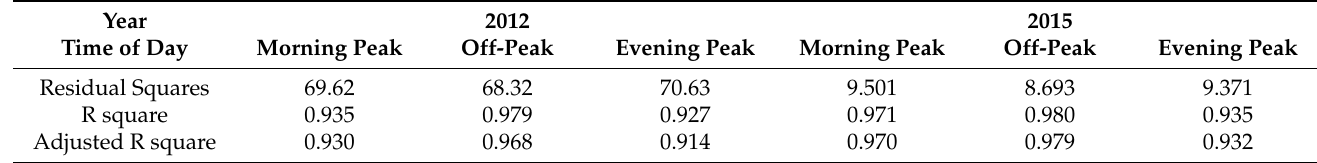
Table 6. Results of the TDA to commercial activities.